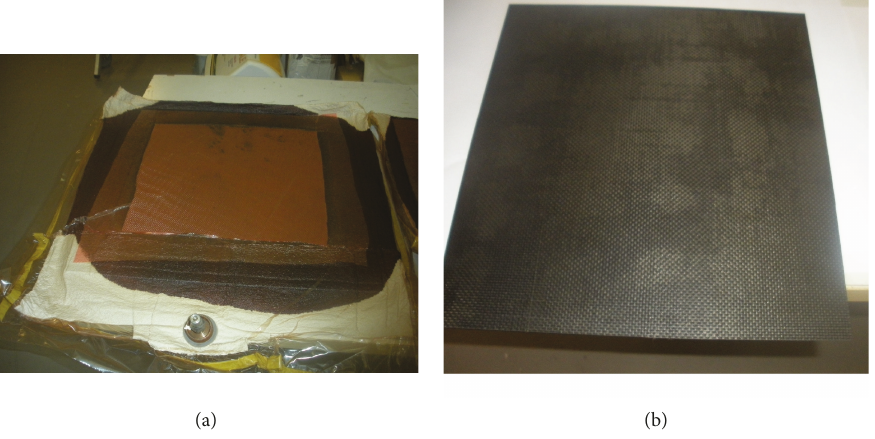
Figure 8: (a) Squeezing of the resin and (b) fi nal result.